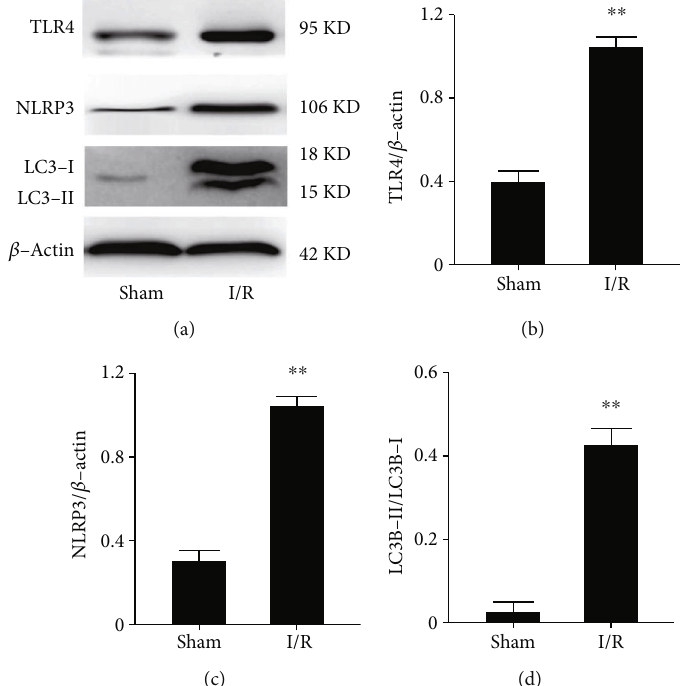
Figure 3: CI/R injury increases the expression of NLRP3, TLR4, and LC3. (a) Protein expression level. (b) The ratio of TLR4 to β -actin. (c) The ratio of NLRP3 to β -actin. (d) The ratio of LC3-I to LC3-II. The data expressed as mean ± SD . ∗∗ P < 0 : 01 vs. control vs.